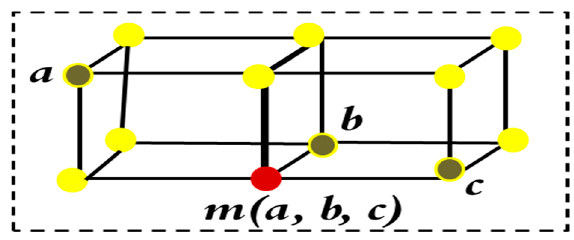
Figure 15. The median of three vertices in a median graph.